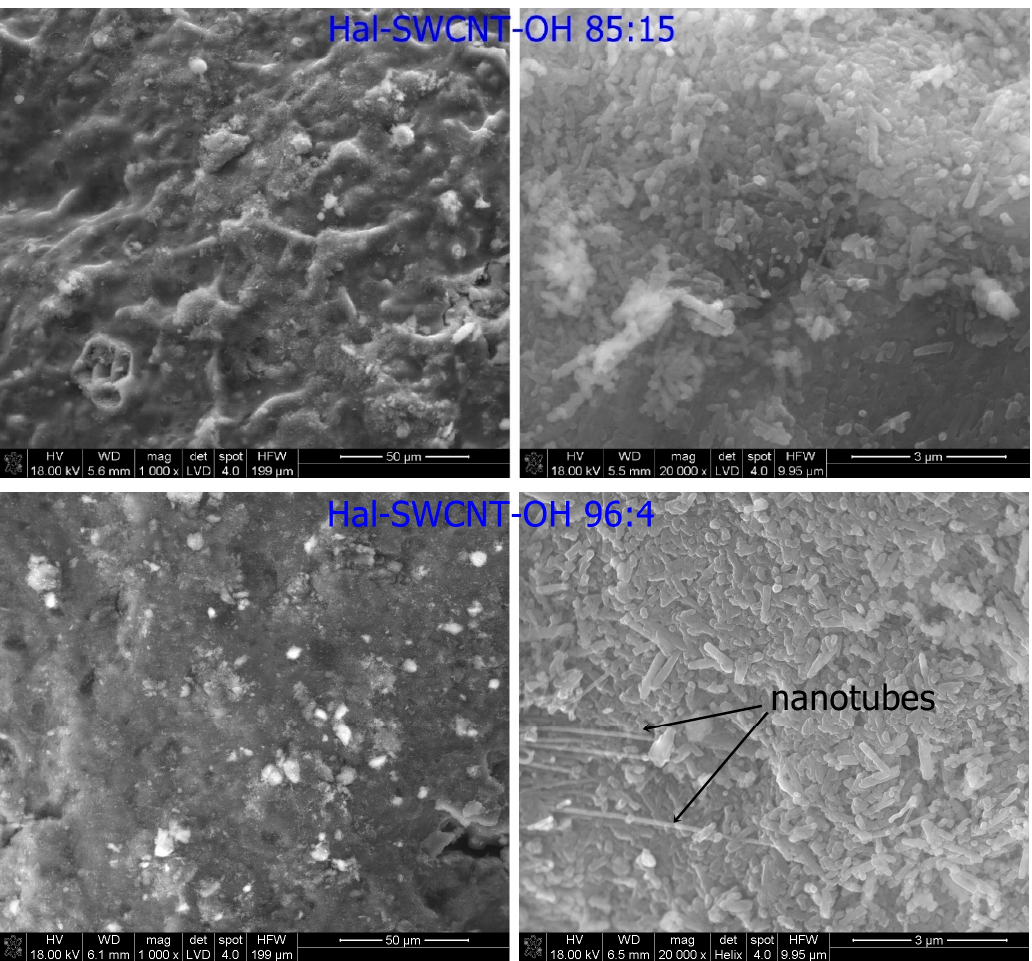
Figure 2. The SEM images of Hal-CNT composites.